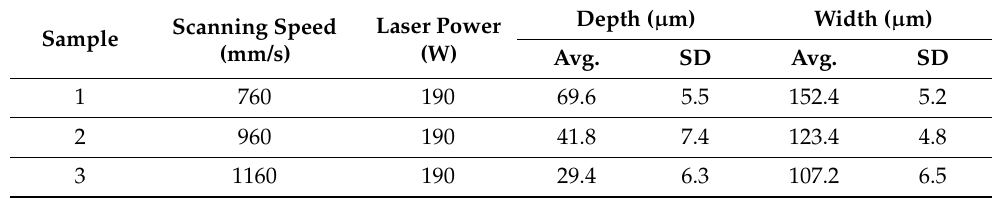
Table 6. Melt pool dimensions tracking